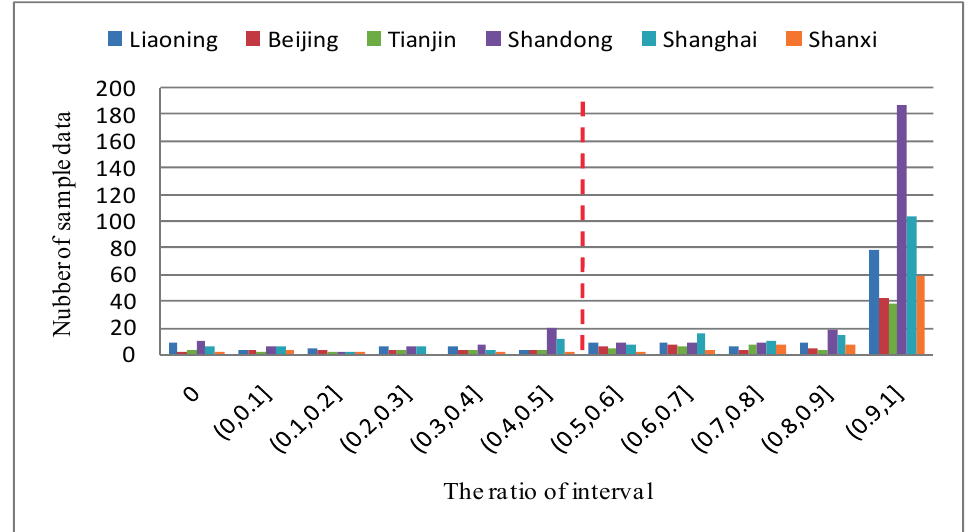
Figure 8. The pixel rate of artificial surfaces in reference zone.